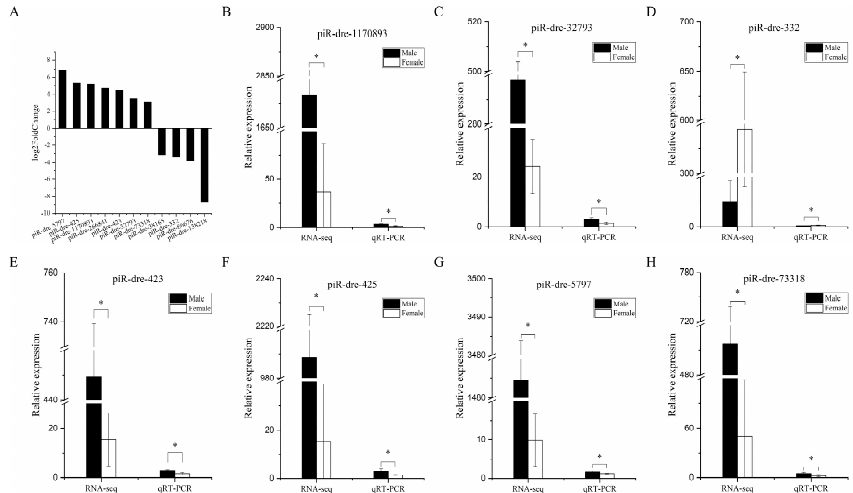
Figure 4. Differential expression of 11 candidate signature piwi-interacting RNAs between male and female greater amberjack based on transcripts per million values from small RNA sequencing, and comparisons of piwi-interacting RNA expression patterns from RNA-sequencing and real-time quantitative polymerase chain reaction analyses. ( A ) Differential expression of 11 candi- date signature piRNAs between male and female groups based on transcripts per million values from small RNA sequencing. The x -axis shows the name of each piwi-interacting RNA, and the y -axis represents the log 2 fold change value of the piwi-interacting RNA. ( B – H ) Comparisons of seven piwi-interacting RNA expression patterns in serum exosomes from RNA-sequencing and real- time quantitative polymerase chain reaction analyses. The x -axis represents RNA-sequencing and real-time quantitative polymerase chain reaction pairs; the y -axis represents the relative expression levels of piwi-interacting RNAs. The black column (left column) represents the relative expression of piwi-interacting RNAs in the male group, and the white column (right column) represents the relative expression of piwi-interacting RNAs in the female group. Data are presented as the mean ± SD, n = 3. *, p < 0.05. ( B ) piR-dre-1170893. ( C ) piR-dre-32793. ( D ) piR-dre-332. ( E ) piR-dre-423. ( F ) piR-dre-425. ( G ) piR-dre-5797. ( H ) piR-dre-73318.